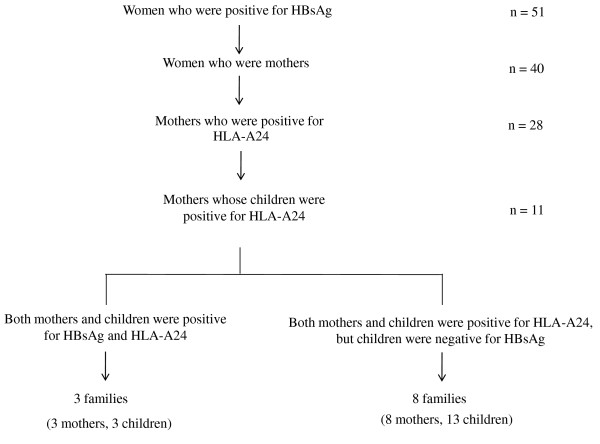
Subject enrollment.